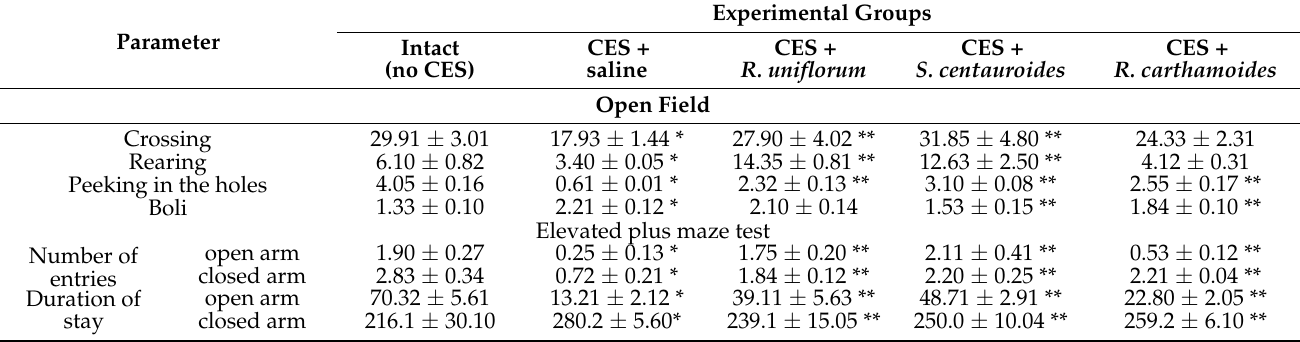
Table 5. The effects of R. uniflorum and S. centauroides extracts on the behavioural activity of rats in the open field and elevated plus maze tests in chronic emotional stress (CES).